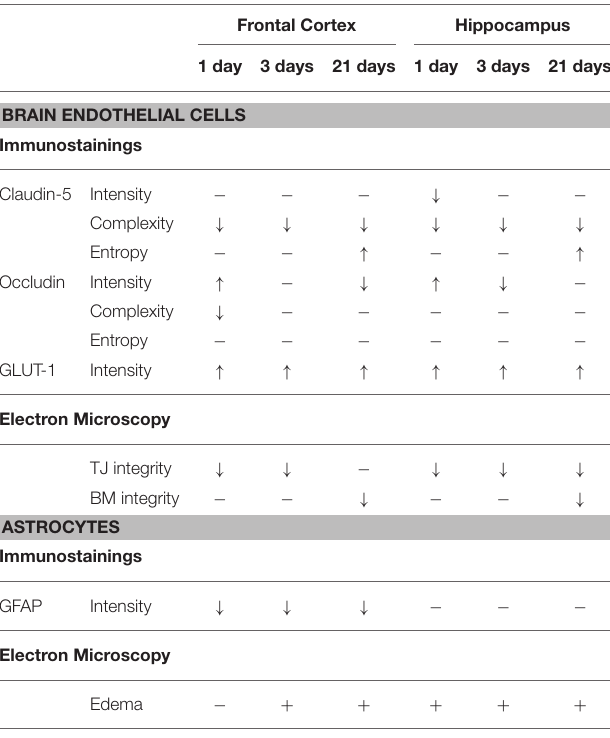
TABLE 2 | Summary of the changes in immunostaining for BBB markers and ultrastructural alterations of the BBB following restraint stress in rats. Frontal